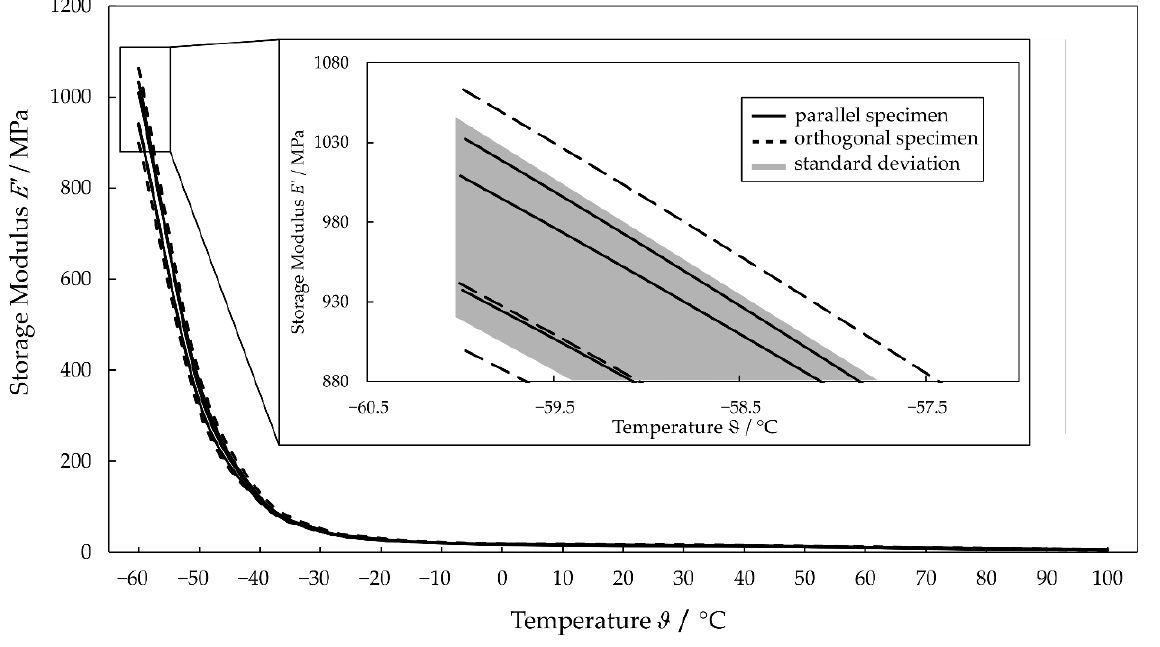
Figure 3. DMA results for the specimen in the parallel and orthogonal directions.